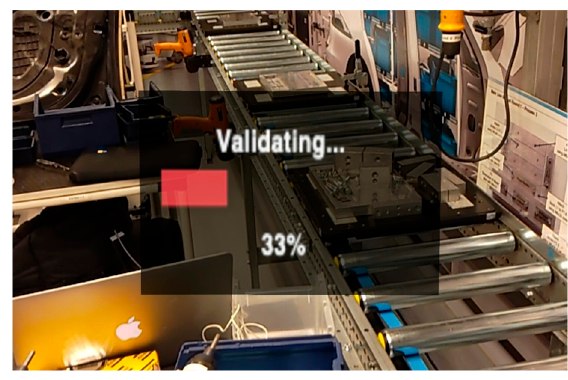
Figure 10. Validation progress overlay.